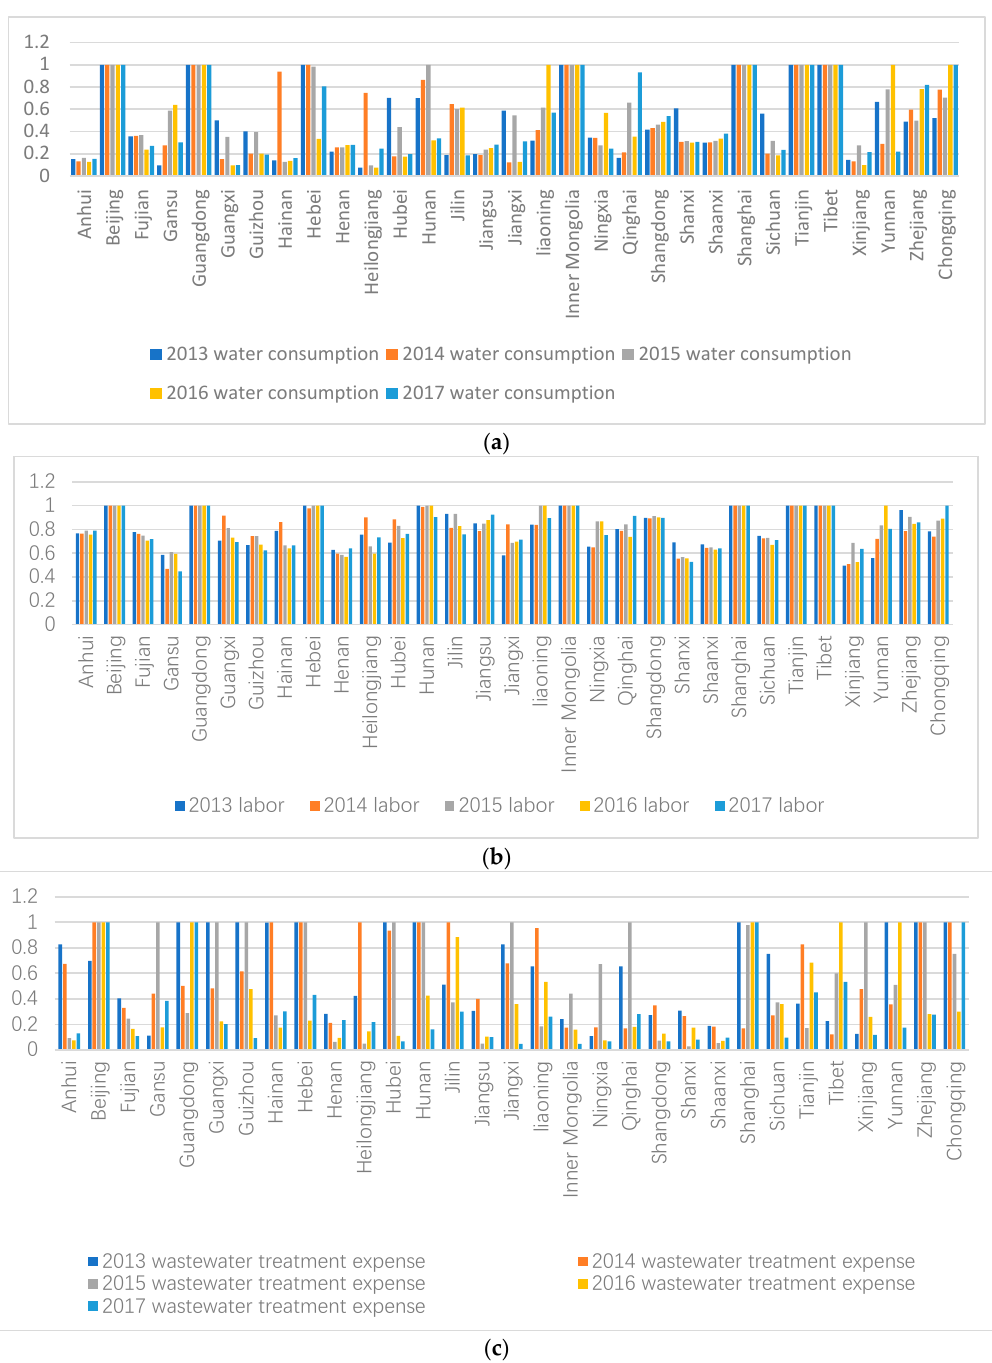
Figure 3a–c reflect the efficiency changes of water consumption, labor force, and wastewater treatment cost.